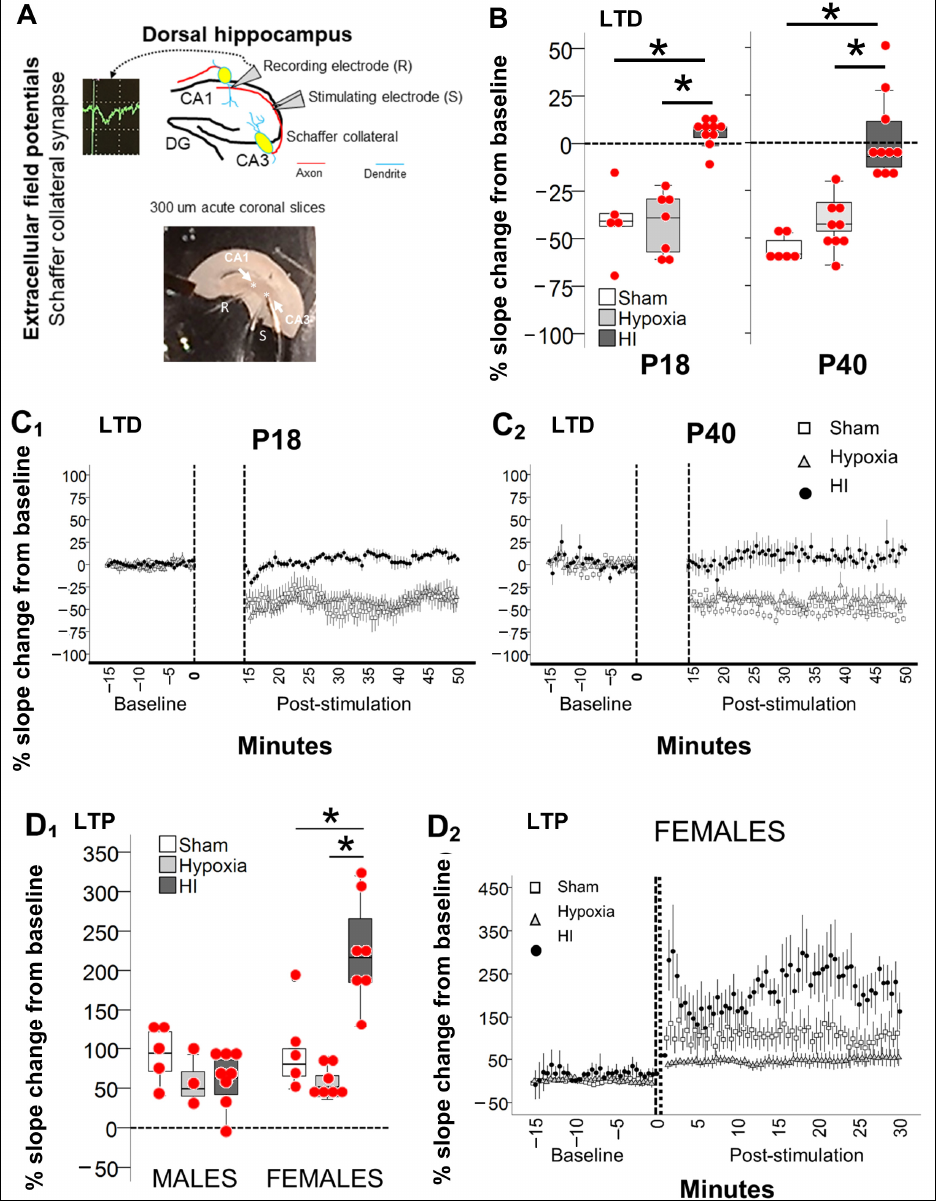
Figure 3. Disruption of the mechanisms of synaptic plasticity after neonatal HI. ( A ) EcFP of the Schaffer collateral synapse was performed in 300 µ m-thick acute coronal slices containing dorsal hippocampus. Bipolar stimulating electrodes (S) were placed in the CA3 radiatum layer (Rd) and monopolar recording electrode (R) was placed in the CA1 Rd to detect extracellularly the